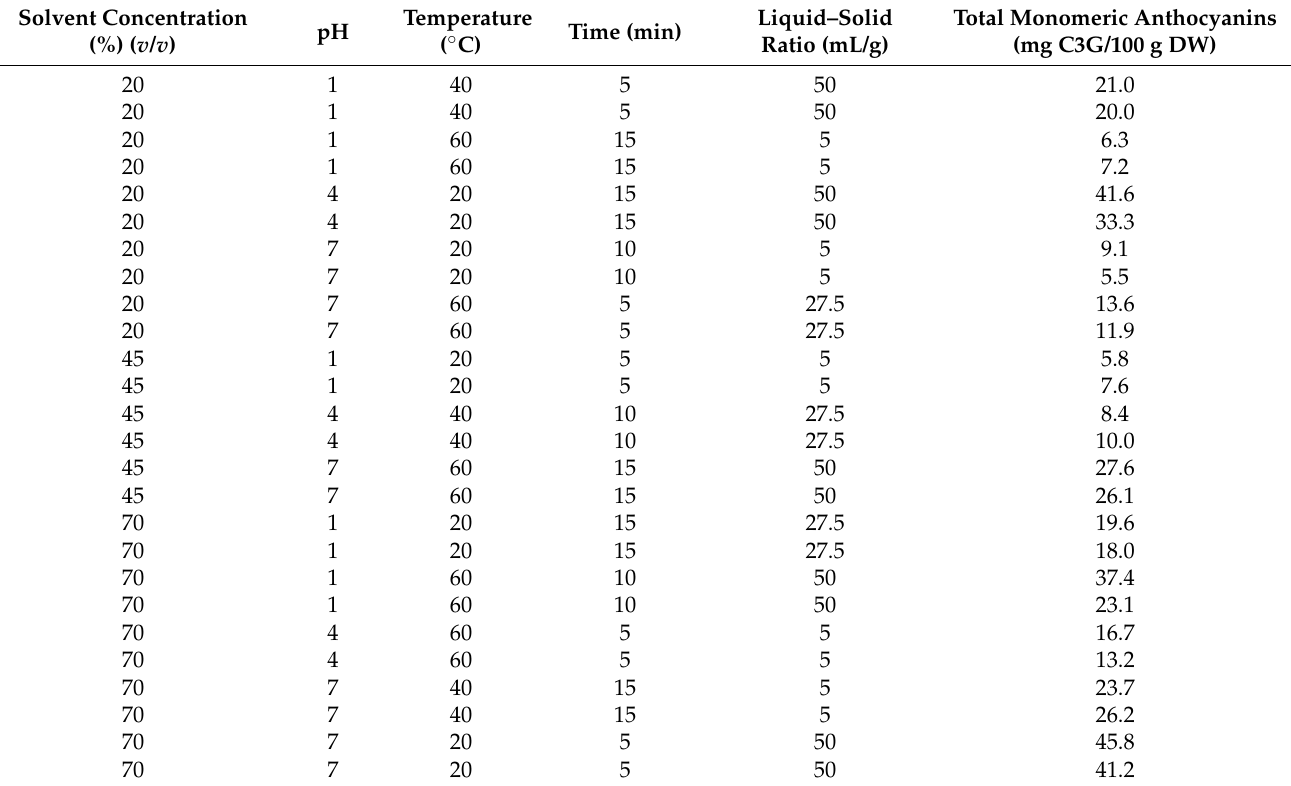
Table 3. Screening design matrix and values of total monomeric anthocyanin concentration. Solvent